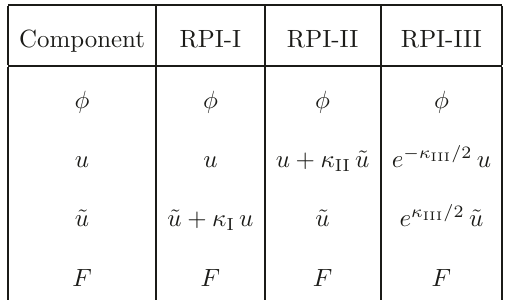
ξ α u α is the ≡ ˜ ξ α u α has the opposite helicity. With ˜ u in ≡